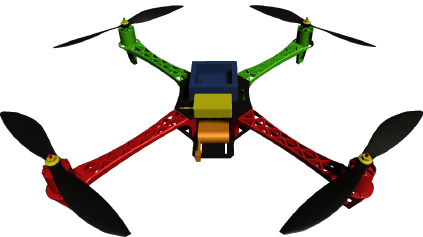
Figure 5. The 3D model of the